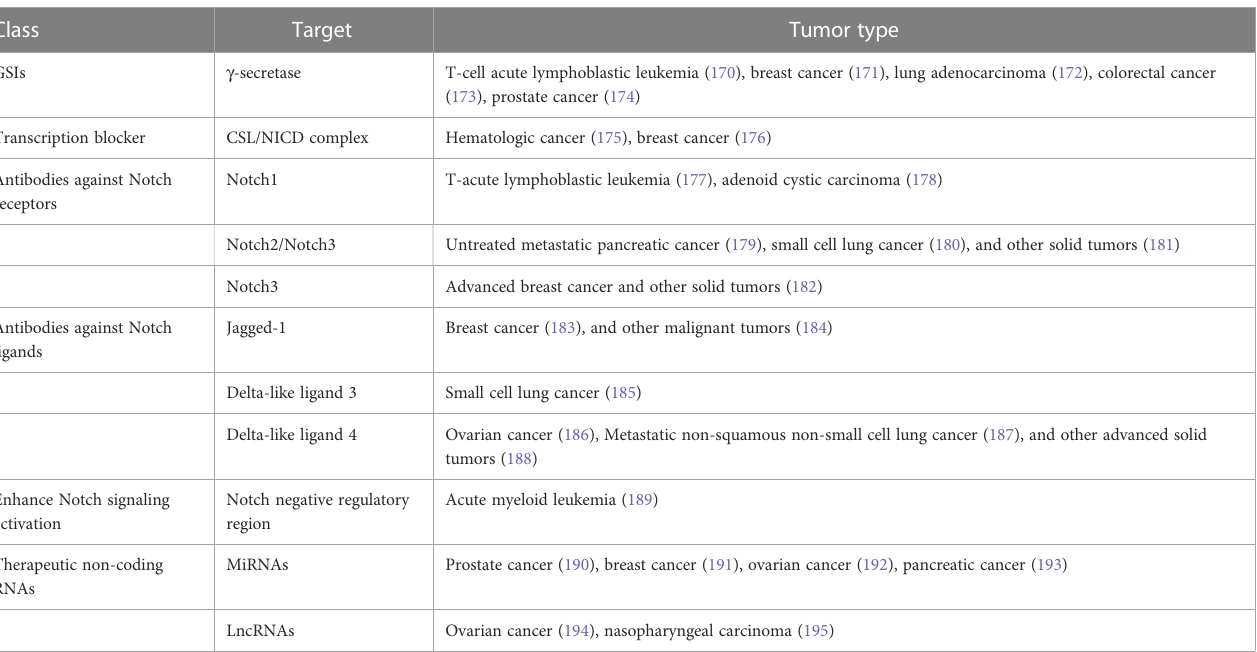
TABLE 3 Therapeutic approaches targeting Notch signaling